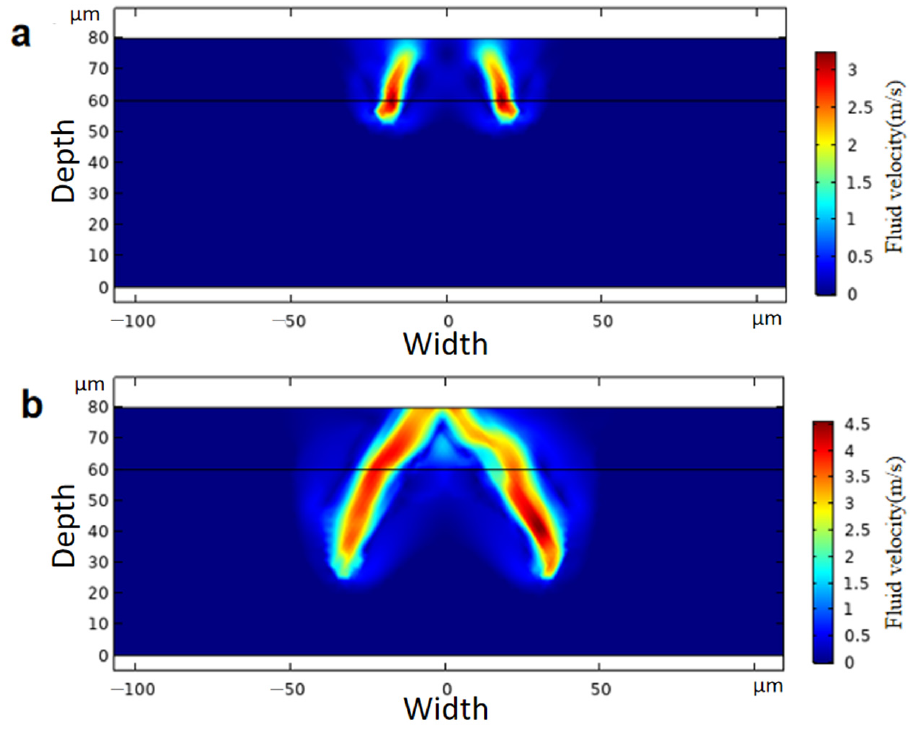
t = 0.034961 ms; ( b ) t = 0.10367